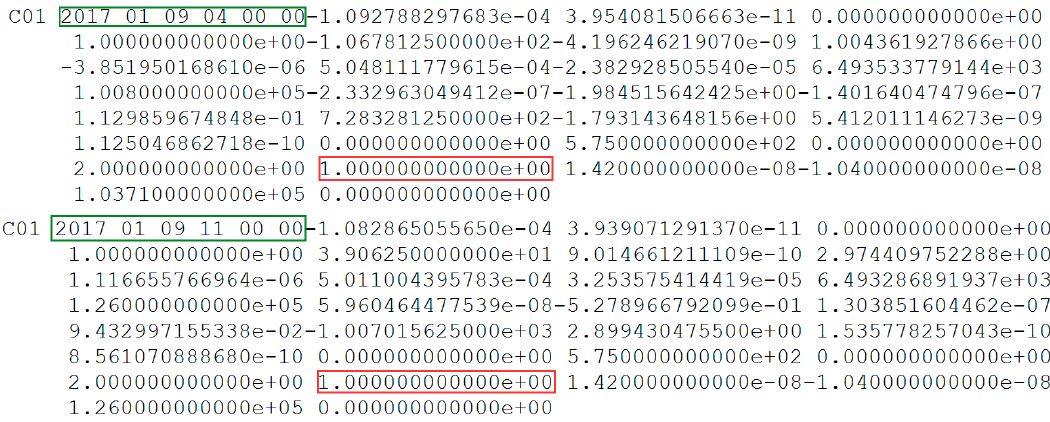
Figure 6. Broadcast ephemeris of C01. The red box highlights the unhealthy status marked as 1. The blue box highlights the healthy status marked as 0. Note that the data are not displayed between 4:00:00 and 11:00:00 to limit the height of the figure and the healthy statuses are all marked as 1 in this period.